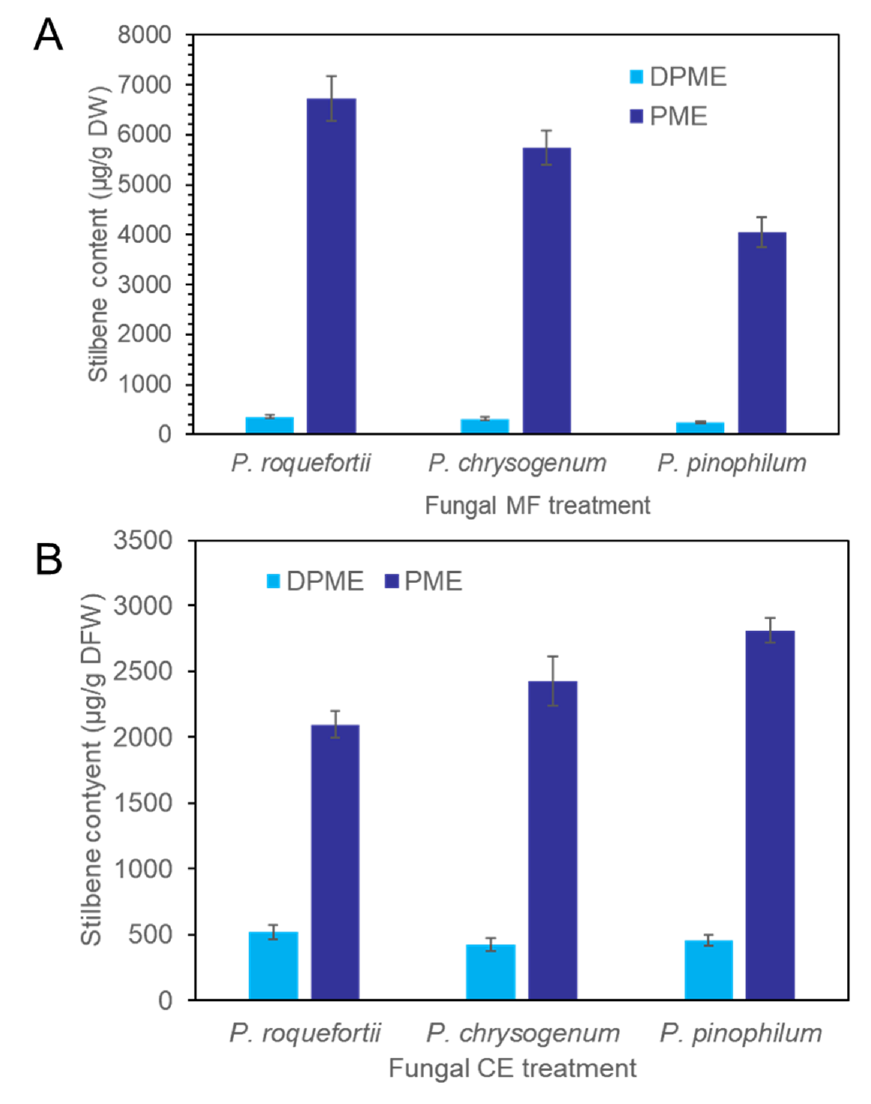
Figure 7. Accumulation of DPME and PME in P. koraiensis cells after fungal elicitor treatment. ( A ) Content of DPME and PME in P. koraiensis cells after MF treatment of P. roquefortii , P. chrysogenum , and P. pinophilum for 3 days. ( B ) Content of DPME and PME in P. koraiensis cells after CE treatment of P. roquefortii , P. chrysogenum , and P. pinophilum for 3